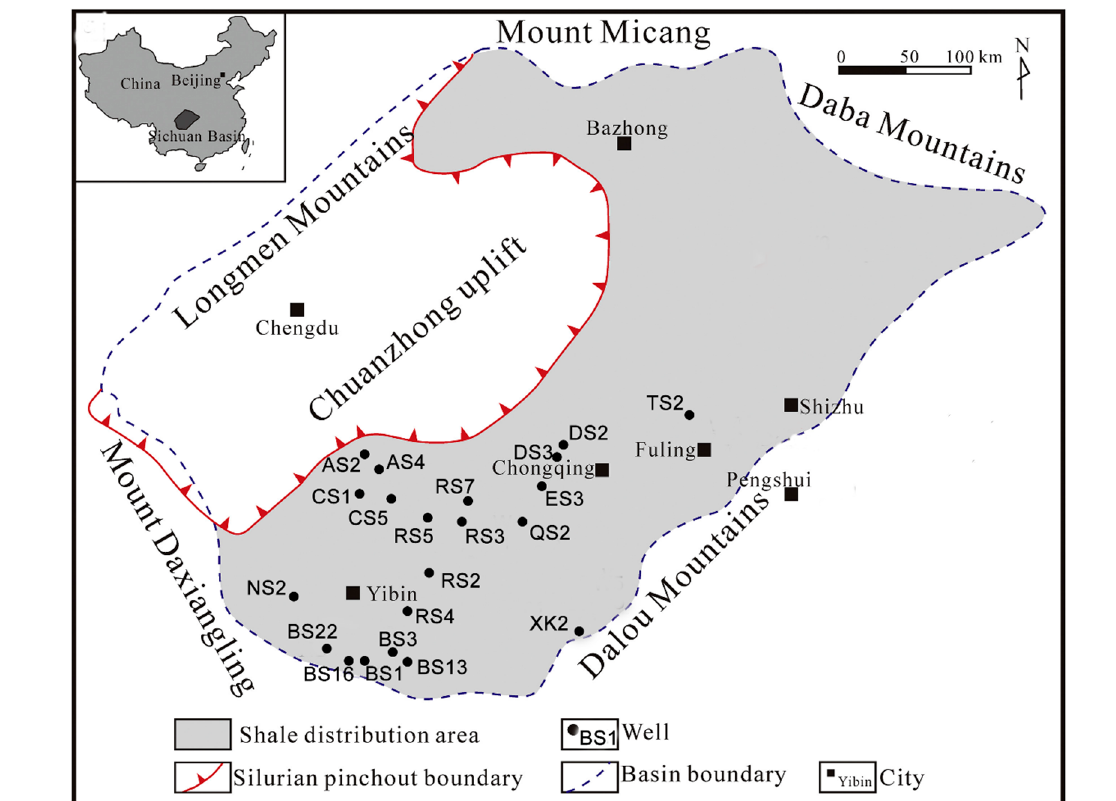
Figure 1. Research area and well locations (modified after Chen et al. [37]). Table 1. Basic reservoir parameters and logging parameters of the